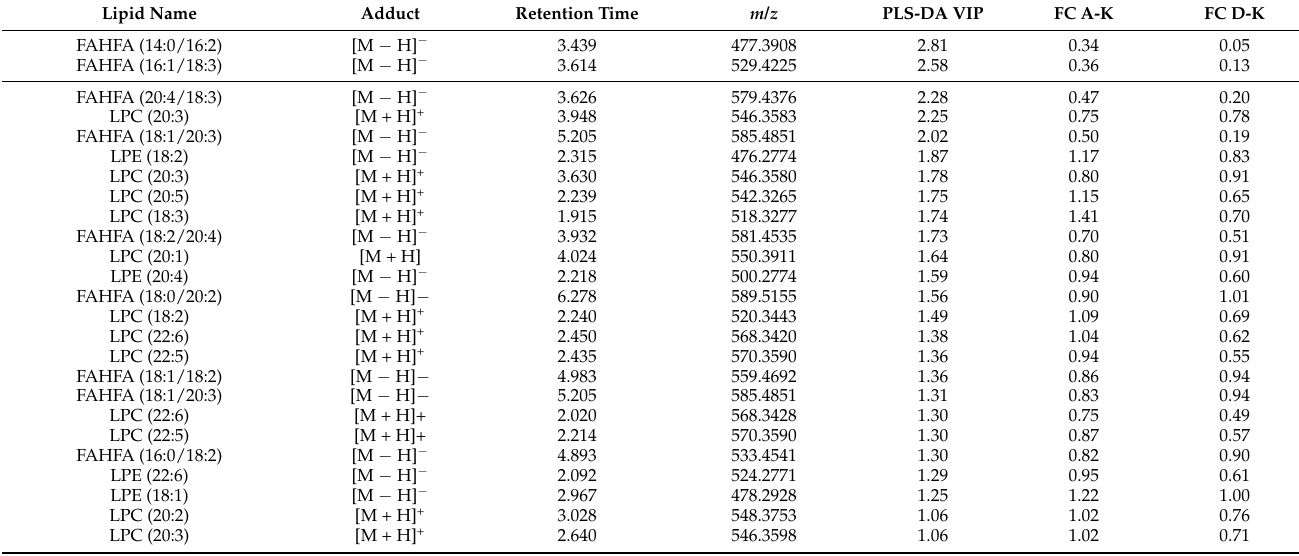
Lipid Name Adduct m /